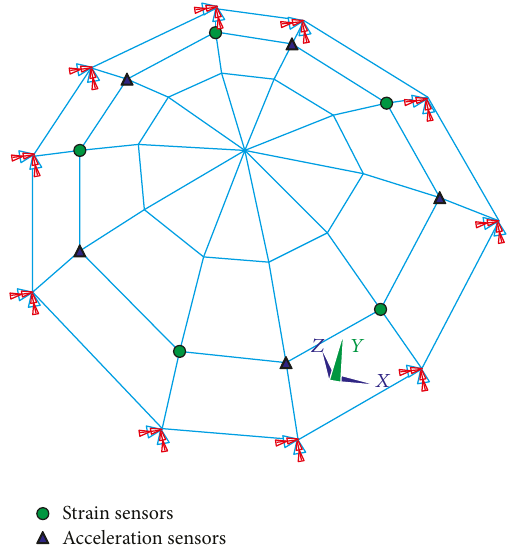
Figure 5: Reticulated dome structure and the sensors